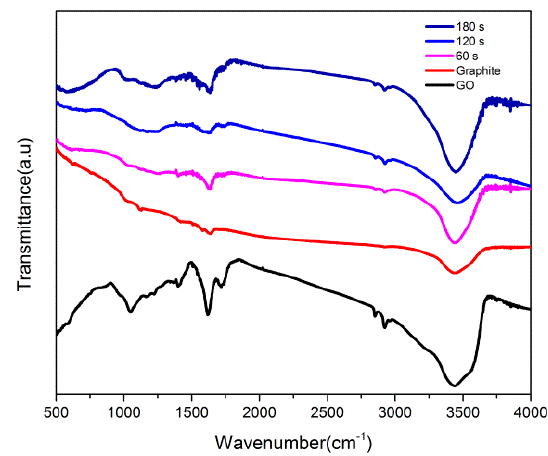
Figure 3. ( a ) Nitrogen adsorption and desorption isotherms of PEGN fabricated using H 2 DBD